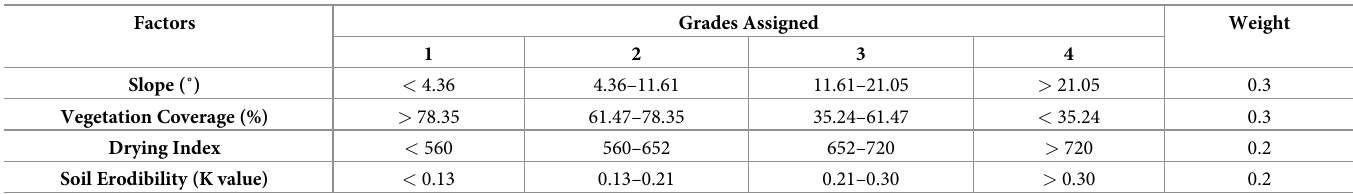
Table 1. Indexes used for eco-environmental vulnerability assessment in the PLEZ.